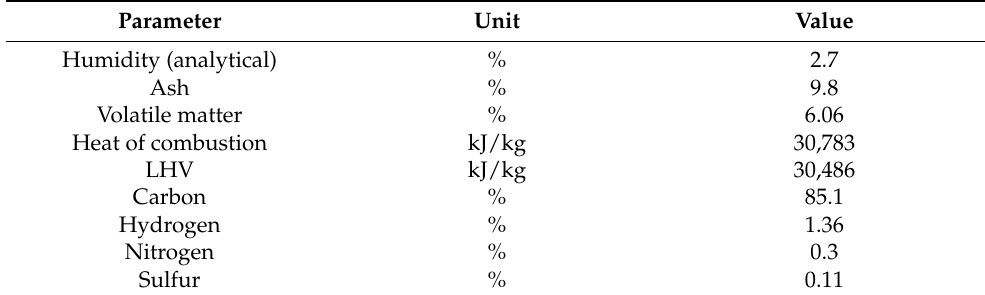
Table 1. Ultimate and proximate analysis for the applied fly ash.